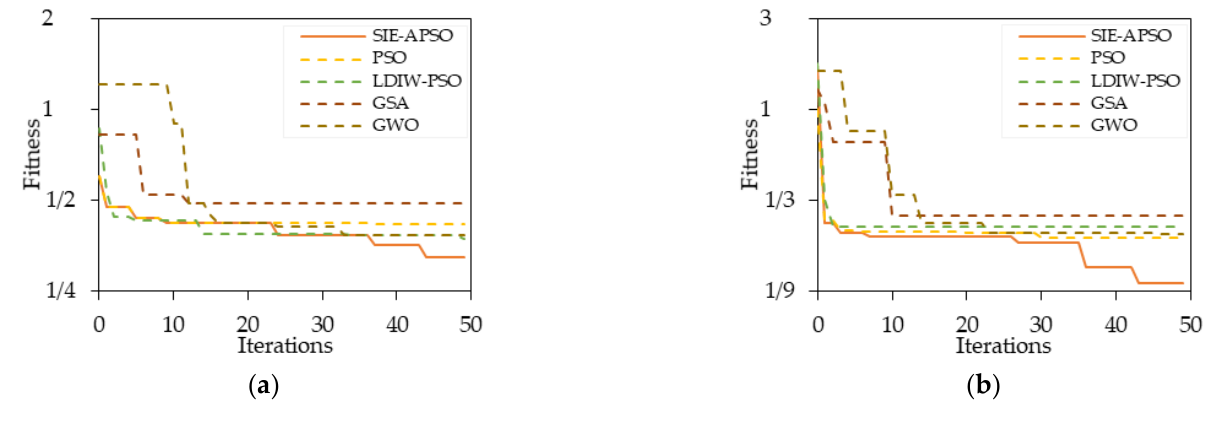
Figure 14. Performance comparison of SIE – APSO (swarm information entropy-based alienation particle swarm optimization), PSO (particle swarm optimization), LDIW – PSO (linear descent inertia weight strategy particle swarm optimization), GSA (gravitational search algorithm), and GWO (standard grey wolf optimizer). Convergence curve of each tuning algorithm. ( a ) Direction along the river, ( b ) Vertical direction.